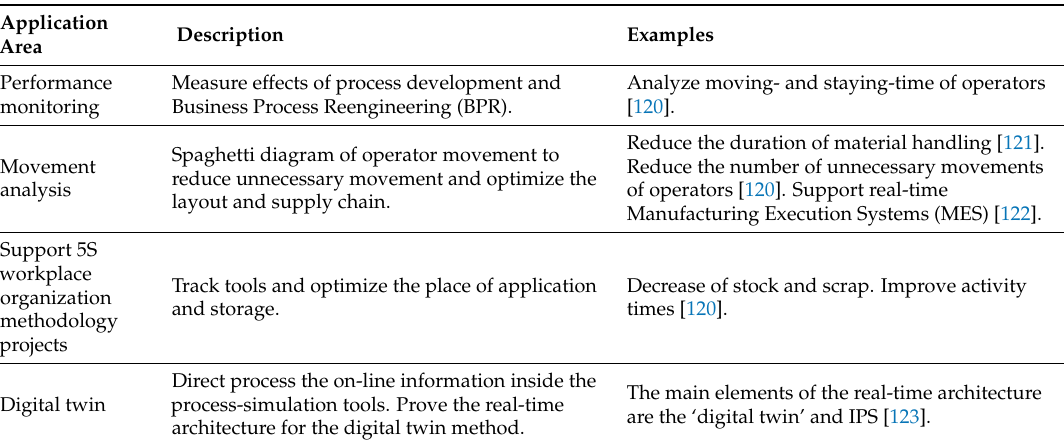
Table 4. Applications of indoor positioning systems in production